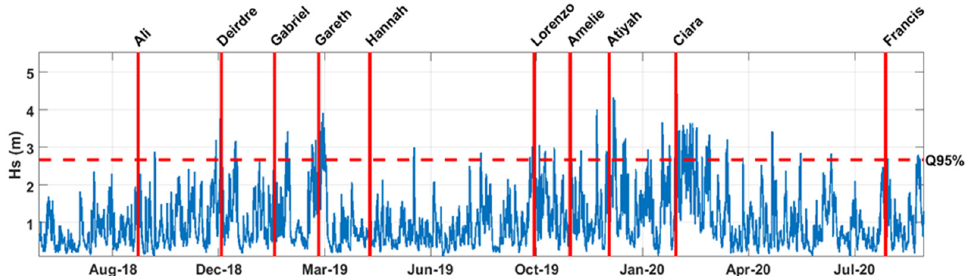
Figure 2. Time series of significant wave height (Hs) from June 2018 to September 2020. The red dotted line represents the quantile 95, used as threshold for the identification of extreme events. The vertical red still lines locate in the time series the 10 storms used for the analysis of transformation of waves in this study.